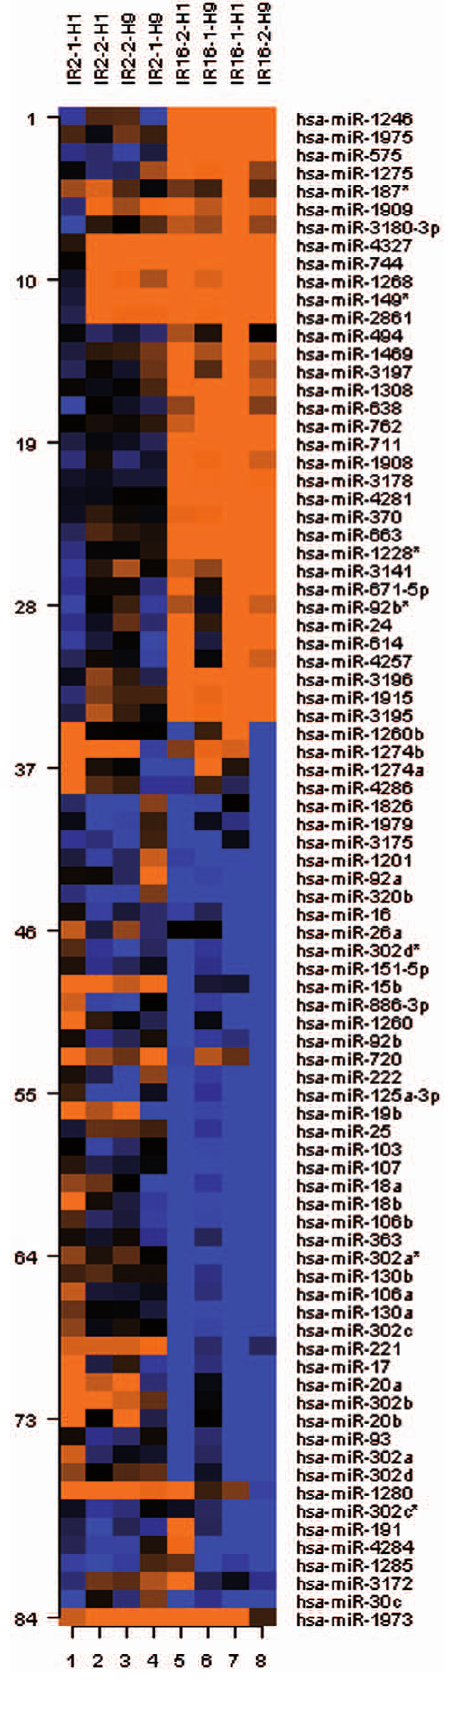
Figure 2. Heatmap representation of differentially expressed miRNA species in human embryonic stem cells after IR exposures (p , 0.05). Clustering analysis was performed on all IR- modulated miRNAs with the signal intensity more than